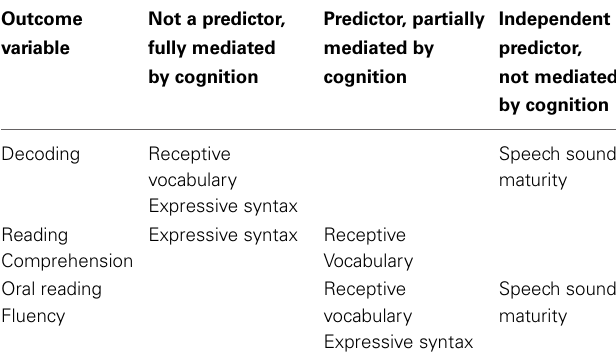
Table 9 | Summary of associations of language and speech skills to reading outcomes with cognition as a